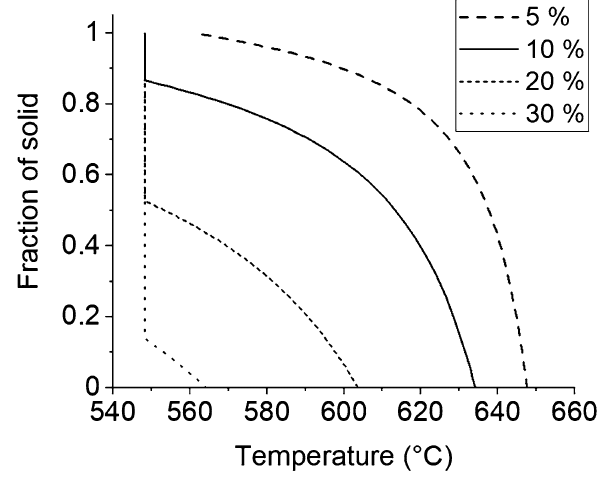
Fig. 4 Fraction of solid vs. temperature for the four different com- positions of the Al-Cu alloys used in this work. The plots were gen- erated using Computherm thermodynamic software using the equilibrium/Lever